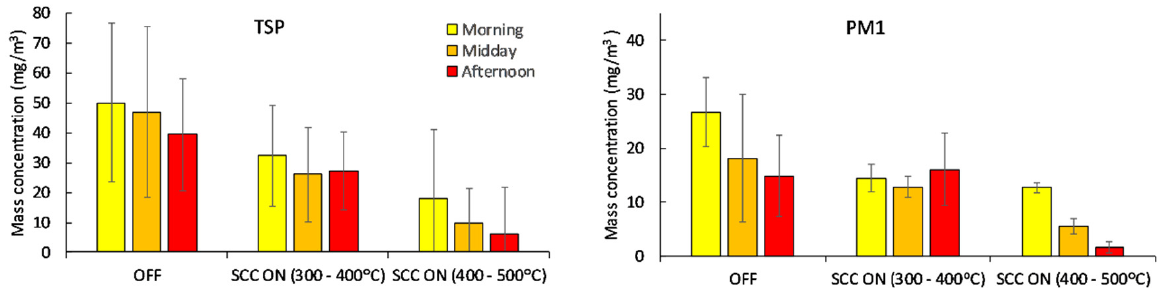
Figure 11. Total suspended particle (TSP) and fine particle (PM1) mass concentrations of flue gases in the long-term experiments with and without usage of a shielded corona charger (SCC) at two different temperature ranges.